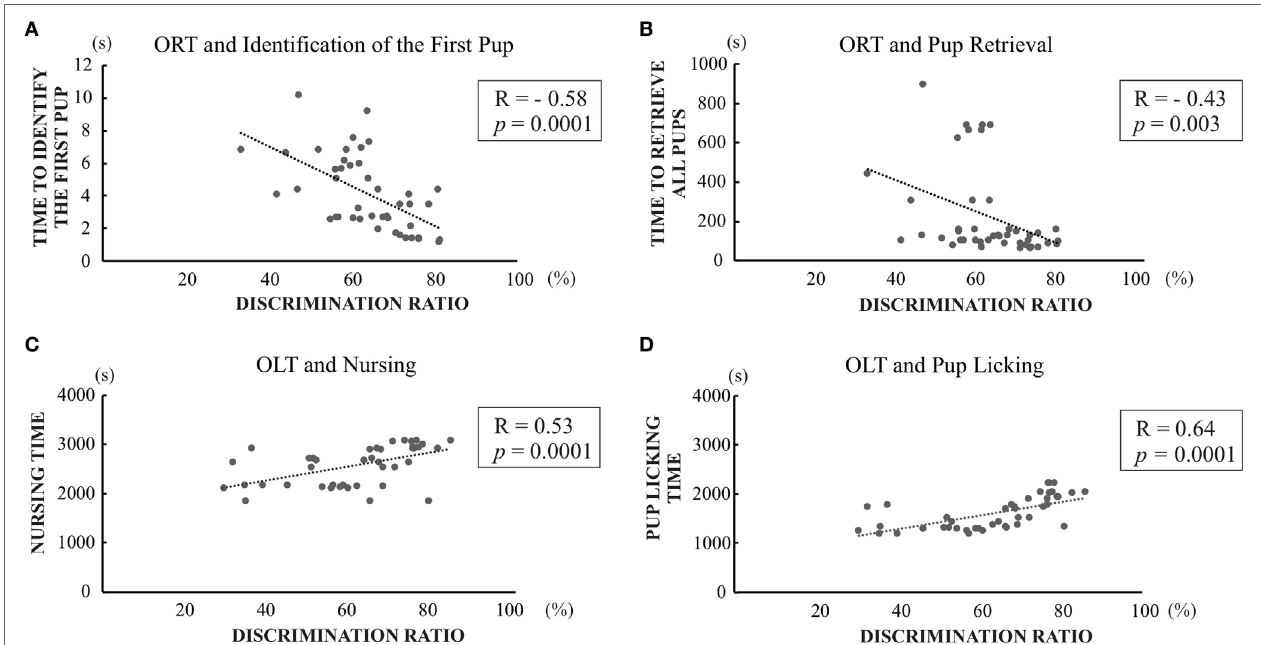
FigUre 7 | Significant correlation graph between discrimination ratios of object recognition test (ORT) or OLT and maternal behavior values. (a) Correlation between discrimination ratios in object recognition and first pup identification time ( R = − 0.58; p = 0.0001). (B) Correlation between discrimination ratios in object recognition and three pup retrieval time ( R = − 0.43; p = 0.003). (c) Correlation between discrimination ratios in object-in-location and nursing time ( R = 0.53; p = 0.0001) (D) Correlation between discrimination ratios in object-in-location and pup-licking time ( R = 0.64; p =